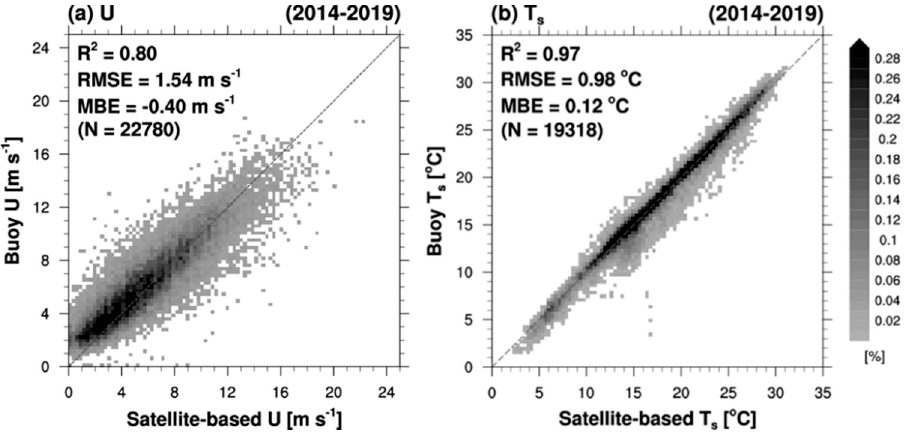
Figure 2. Comparison of daily mean ( a ) wind speed (U, m s − 1 ) and ( b ) sea surface temperature (T s , °C) derived from satellite and buoy observations during the period 2014–2019. The dashed line is the 1:1 line. The color scale represents the density (%) of the data points. Table 1. Empirical coefficients for estimating Q a and T a .